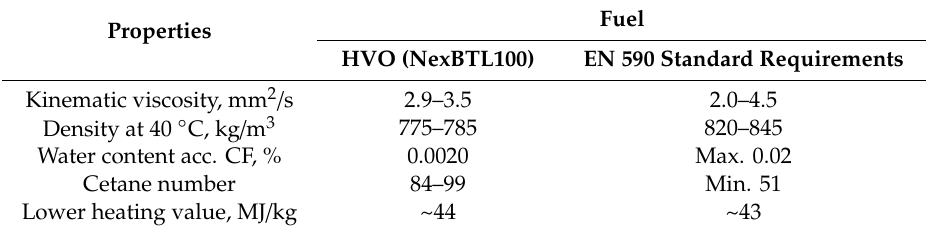
Table 1. The comparison of the di ff erent HVO (Hydrotreated Vegetable Oil) fuel mixtures and pure HVO to the requirements of standard EN 590